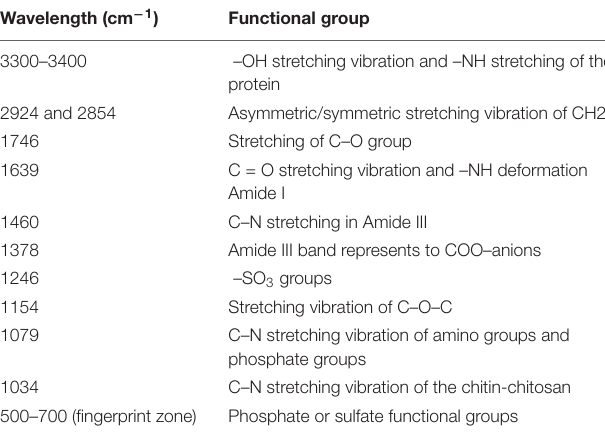
TABLE 4 | Main functional groups of FTIR